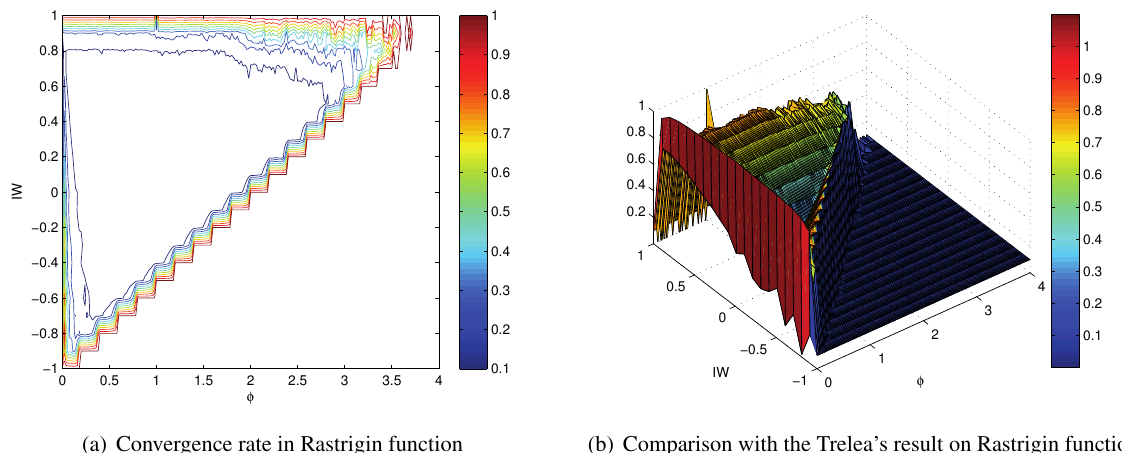
Figure 13: Convergence rate in Rastrigin function and the major discrepancy landscape between Fig. 12(a) and the right subgraph of Fig. 2 in [31] on Rastrigin function.